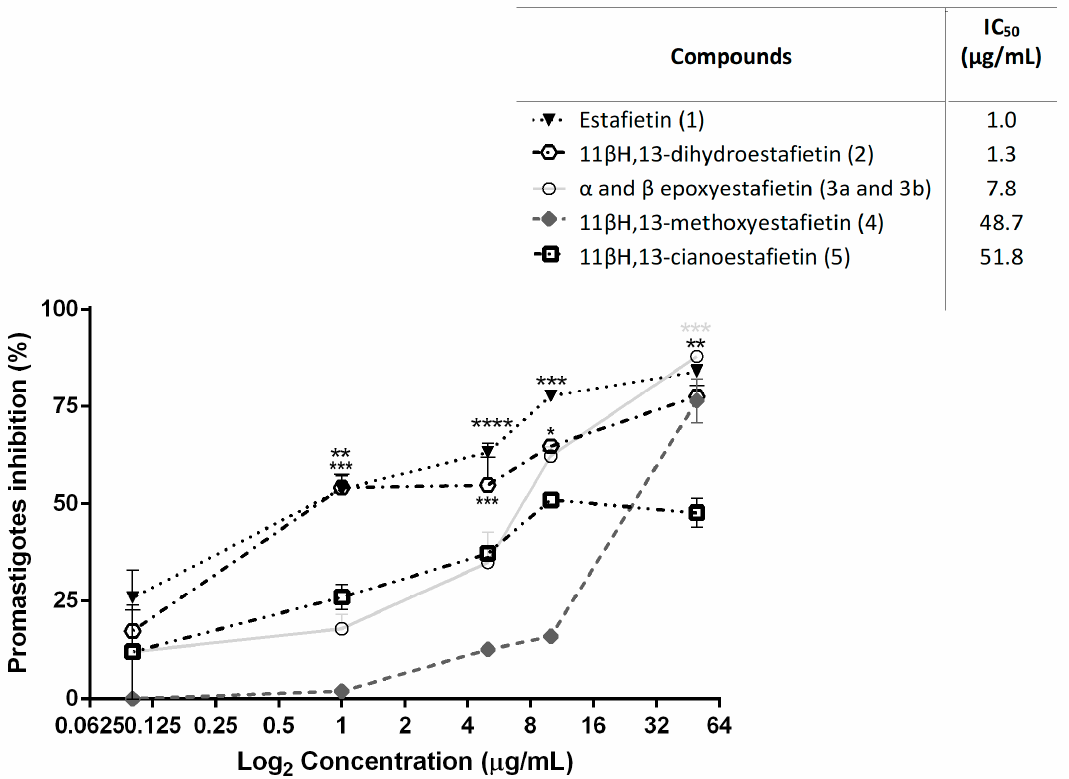
Figure 4. Leishmanicidal activity of estafietin ( 1 ) and estafietin derivatives ( 2 – 5 ) on L. braziliensis promastigotes. Parasites were cultured for 72 h in the presence of each compound (0–50 µ g/mL). The inhibition of parasite growth was evaluated by a [ 3 H] thymidine uptake assay. The percentage of inhibition was calculated as 100 − [(cpm of treated parasites)/(cpm of untreated parasites)] × 100. Values represent mean ± SEM from three independent experiments carried out in triplicate. Each treatment was compared to controls: parasites incubated with culture medium only. * p < 0.05, ** p < 0.01 and *** p < 0.005.